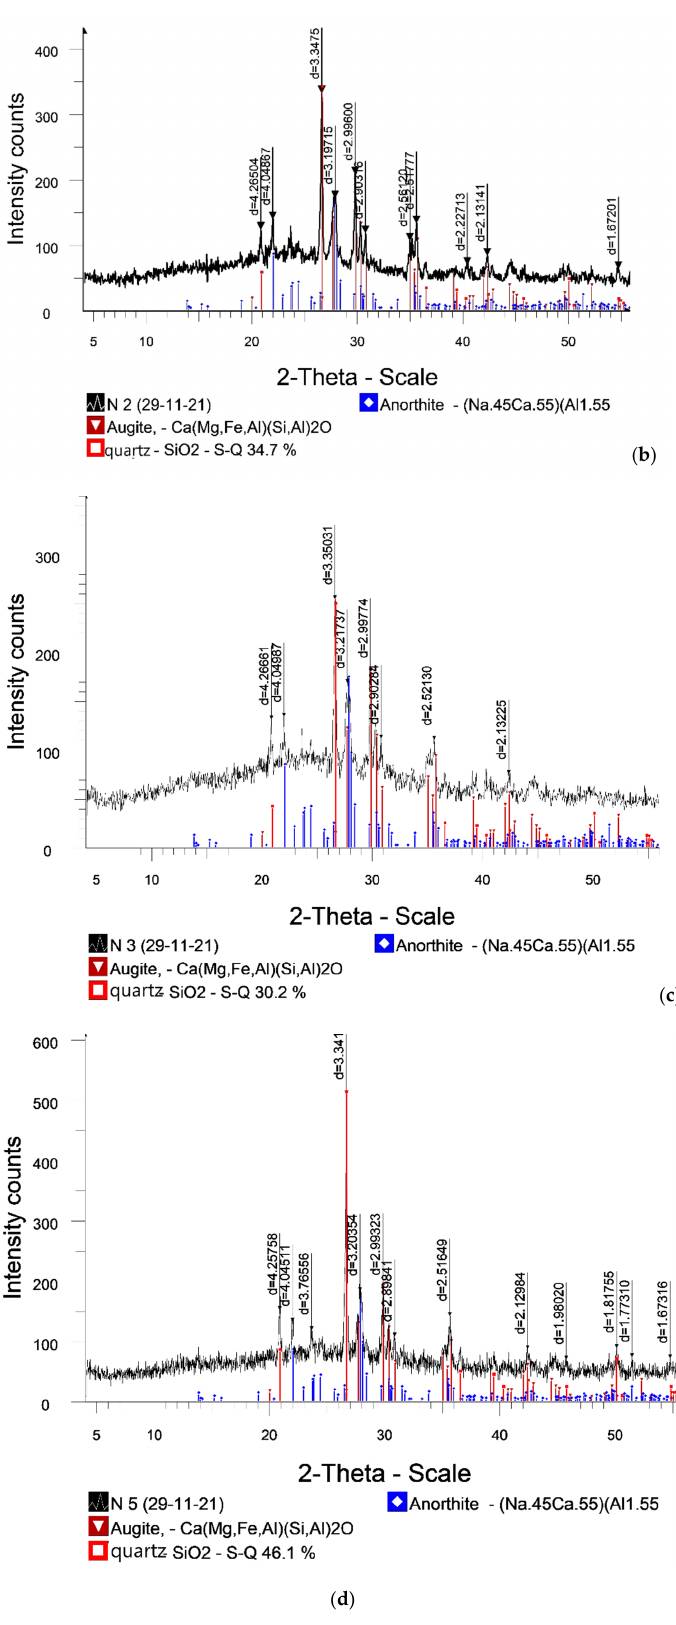
Figure 6. Diffractograms of loam-based samples after burning at 1170 °C: ( a ) without additives. ( b ) With the addition of 15% diatomite from Zhalpak deposit. ( c ) With the addition of 15% diatomite from Utesai deposit. ( d ) With the addition of 15% bentonite clay. All of the above diffraction peaks belong to the above phases. The results of the semi- quantitative X-ray diffraction analysis are shown in Table 6.